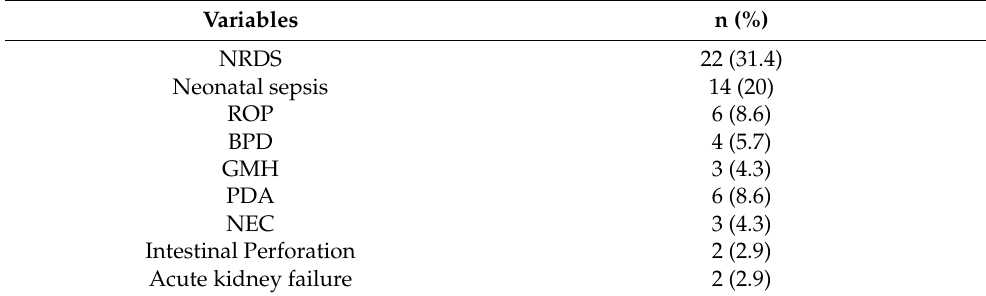
Table 2. Adverse neonatal outcome